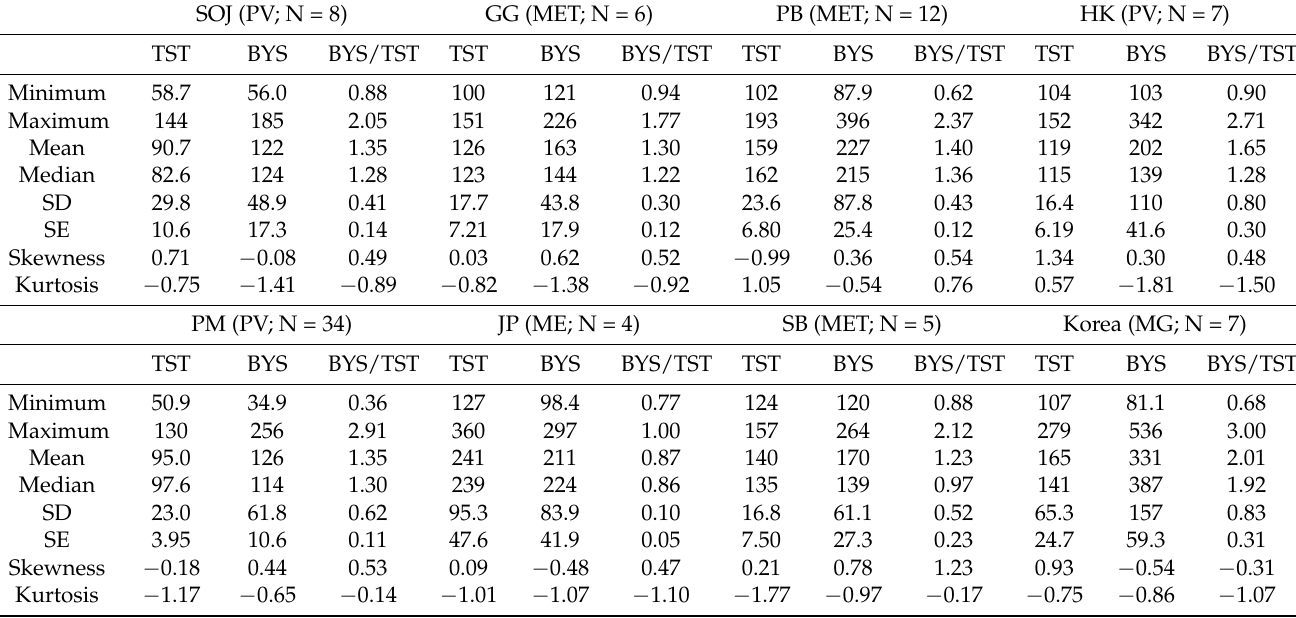
Table 2. Overall statistics of concentrations (mg/kg dry weight) of Zn in the byssus (BYS) and total soft tissues (TST) of Perna viridis and their ratios (BYS/TST), collected from 34 populations in the coastal waters of Peninsular Malaysia (PM) and 2 sites in the Straits of Johore (SOJ) during experiment from the present study, along with those reported in the